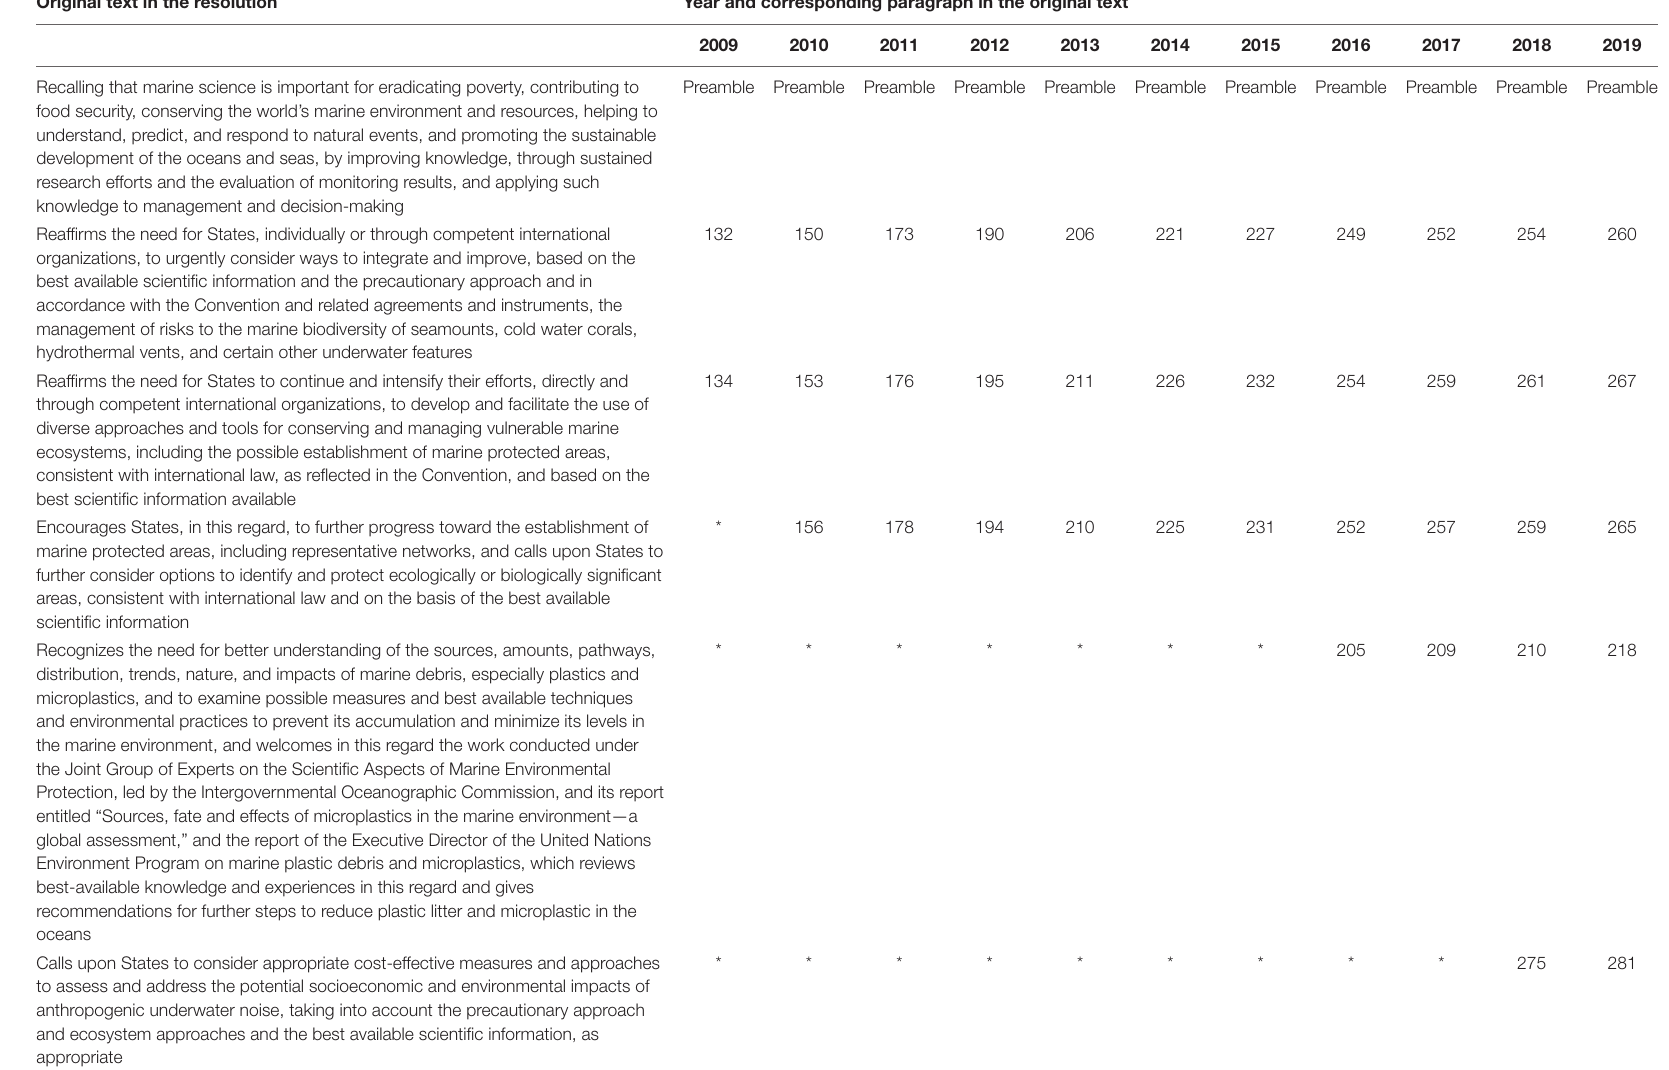
TABLE 1 | Exact extracts from the United Nations General Assembly resolutions on oceans and the law of the sea in which references to marine science or scientific are made. Ten years of exerts (2009–19) a . Original text in the